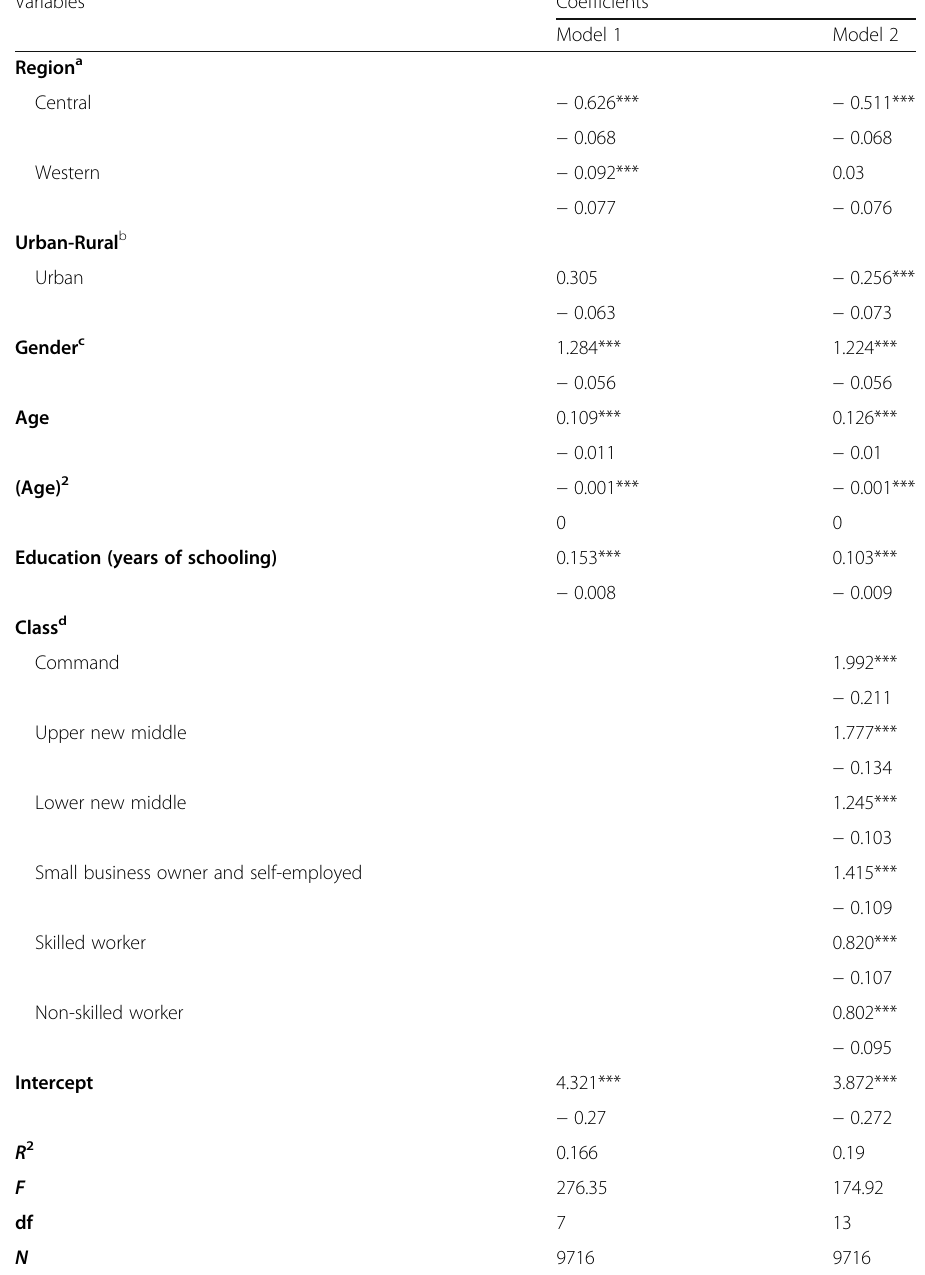
upper-middle class and the command class is not significant ( p = 0.319), but that between the new upper-middle class and the new lower-middle class is ( p < 0.000). The new upper-middle class has a higher income than the old middle class with signifi- cance ( p < 0.009), but the income difference between the new lower-middle class and Table 9 OLS regression of logarithm of annual income on class in transitional China: 2010 CGSS Variables Coefficients Model 1 Model 2 Region a Central − 0.626*** − 0.511*** − 0.068 − 0.068 Western − 0.092*** 0.03 − 0.077 − 0.076 Urban-Rural b Urban 0.305 −